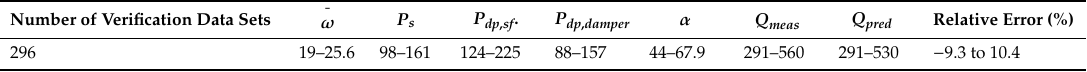
Table 9. Comparison of measured data, prediction airflow rate, and relative